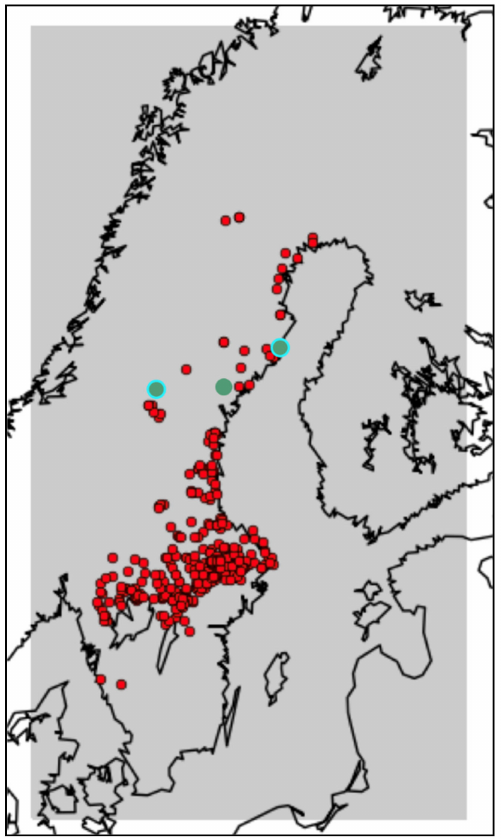
Figure 1. Map of Sweden and surroundings showing site locations and data scope. Reference sites are marked with green dots (earlier study) and teal circles (current study), while survey and basic sites are marked with red